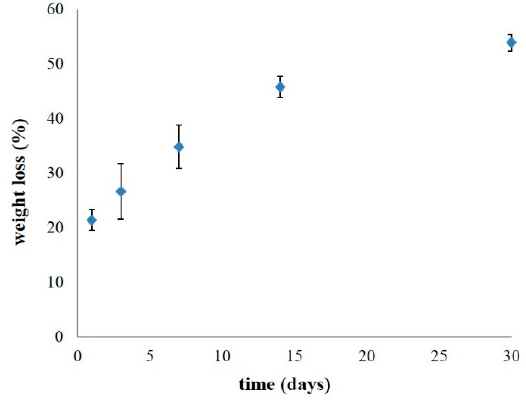
Figure 6. Degradation test results of CHTP. Error bars represent standard deviations of triplicate measurements.